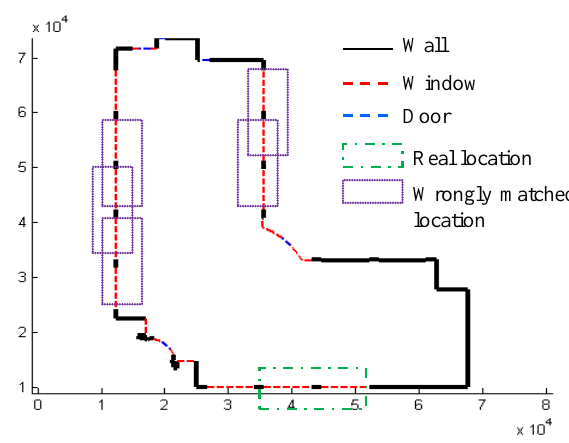
Figure 7. Multiple matches of the ground floor plan